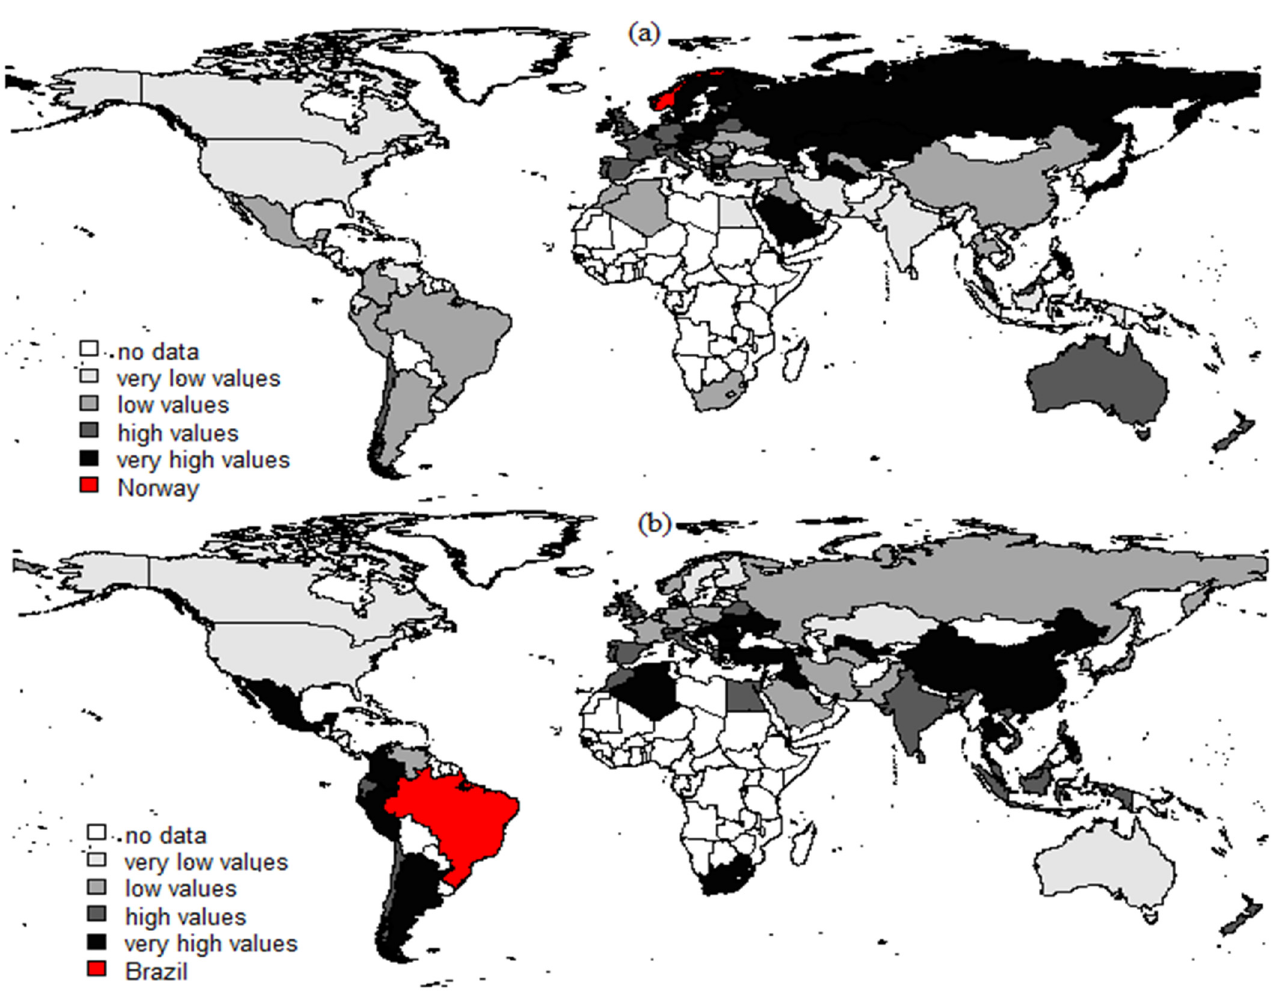
Figure 6. Dependence of the CO 2 emissions of all other countries on the share of energy from renewable sources out of the total energy consumption in ( a ) Norway and ( b ) Brazil.